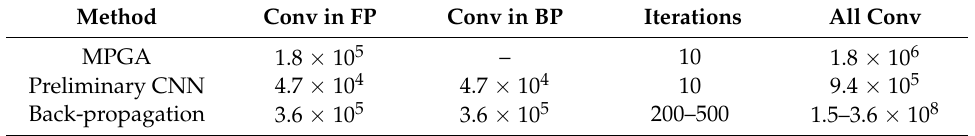
Table 3. Convolutions used in MPGA optimization and back-propagation in the first